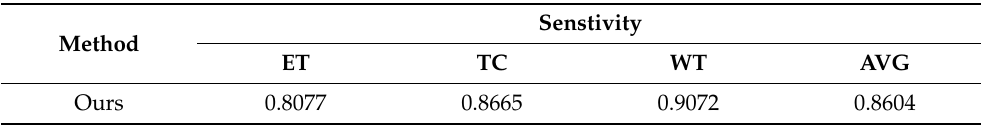
Table 5. Quantitative sensitivity analysis of the segmentation performance in brain tumour segmen- tation tasks of the BraTS